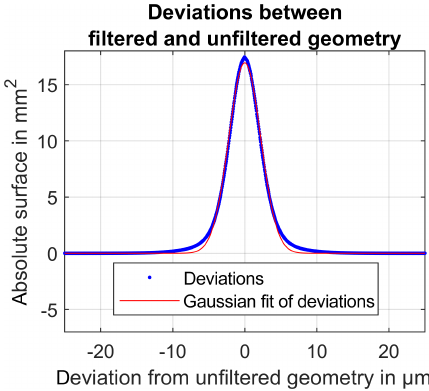
Figure 5. Alignment of the sprocket of the reference geometry (grey) and the 20 measurement repetitions (various colours) after the registration